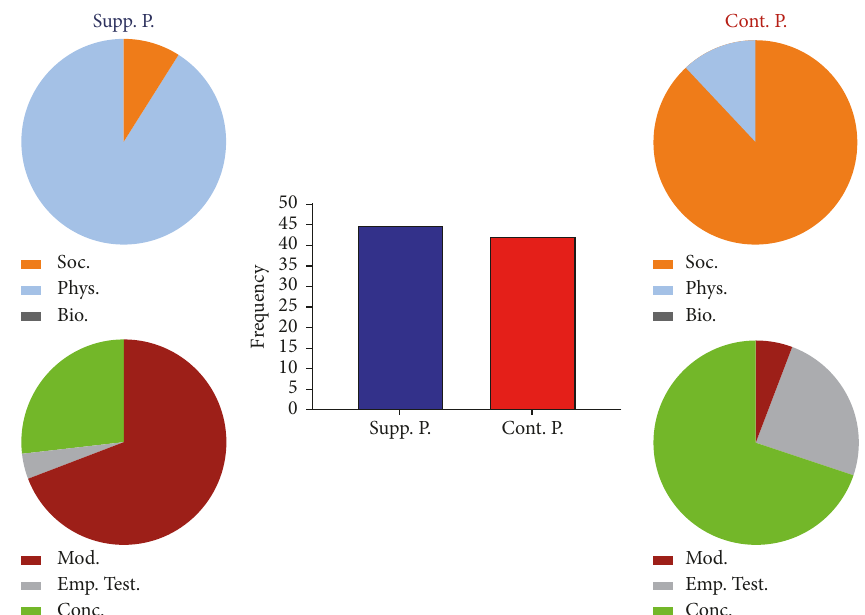
Figure 1: Visualising the frequencyof quoteson the termpanic thatconvey supportfor thetheory versusthosethatchallengeit. Thepie charts on the left show the frequency of the supporting comments across the disciplines (on the top) and across the study types (in the bottom). Similarly, the pie chartson the rightshow thefrequency of the contradictingcomments again across thedisciplines (on the top) and across the study types (in the bottom). The column chart in the middle compares the frequency of these comments in total regardless of the discipline or type of the study from which the comments were